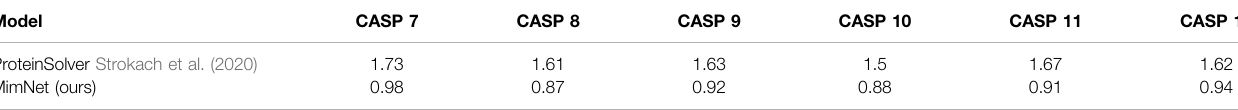
TABLE 1 | KL-divergence comparison of recent Protein-Design methods. Model